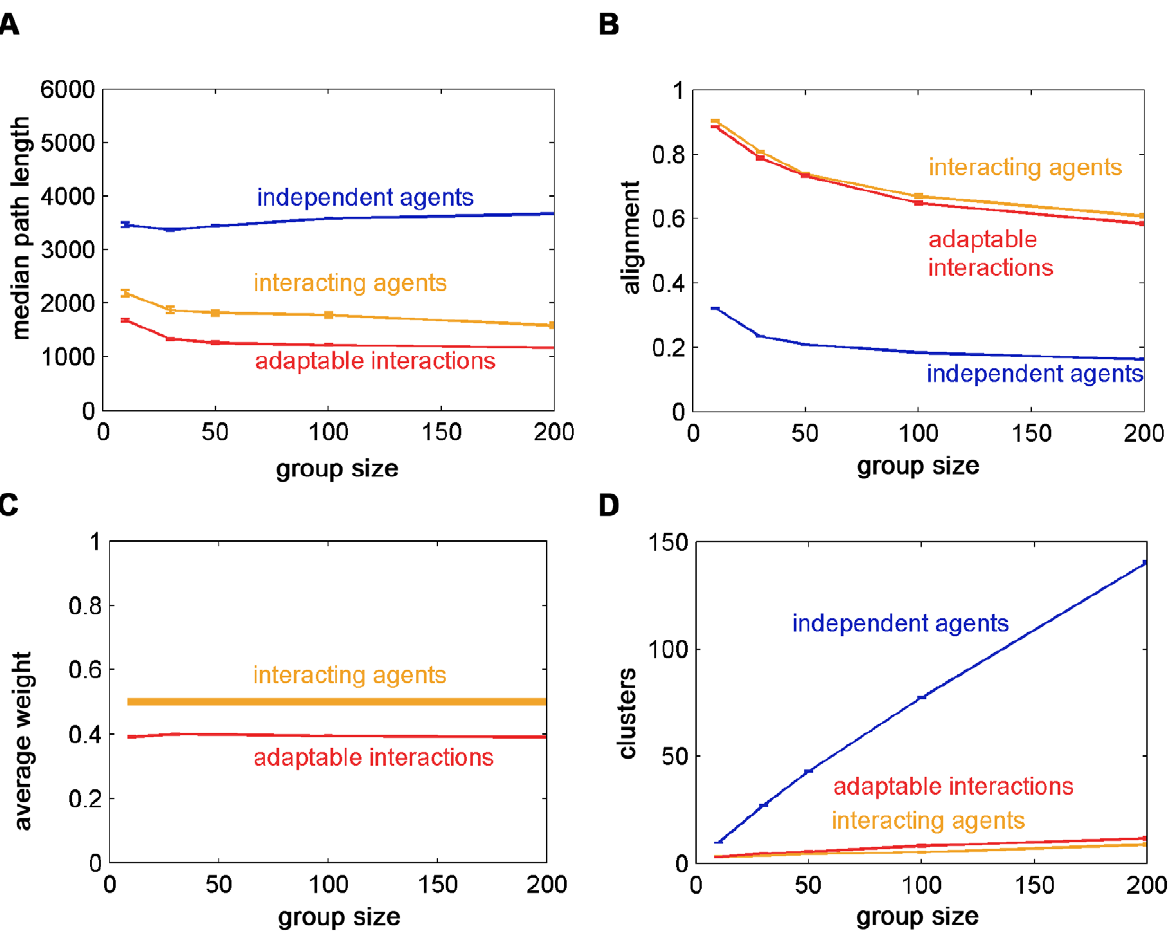
Figure 10. Comparison of the interaction mechanisms as a function of group size. A. Agents with adaptable interactions find the target faster than interacting agents. Both are much faster than independent agents. The median path length increases as a function of group size for independent agents due to an increase in the sample size. It decreases for interacting agents and for agents with adaptable interactions due to the collection of information from more agents. B. Alignment decreases as a function of group size. Independent agents are not aligned while agents with adaptable interactions are less aligned than interacting agents. C. For agents with adaptable interactions, group average weight is not strongly dependent on group size. The average weight of agents with adaptable interactions is lower than the constant predetermined weight of interacting agents. Nonlinearity cause lower average weights, which correspond to higher conformism and implies higher group alignment, to couple with lower alignment. D. The average number of clusters increases with the group size. Independent agents are highly clustered while agents with adaptable interactions are more clustered than interacting agents. Simulation parameters are as in Figure 8, apart from N . Error bars represent standard error.